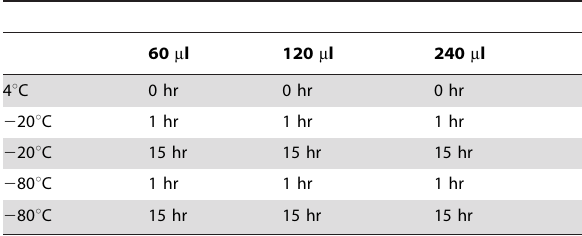
Table 2. Treatments of ethanol volume, incubation temperature and time on DNA